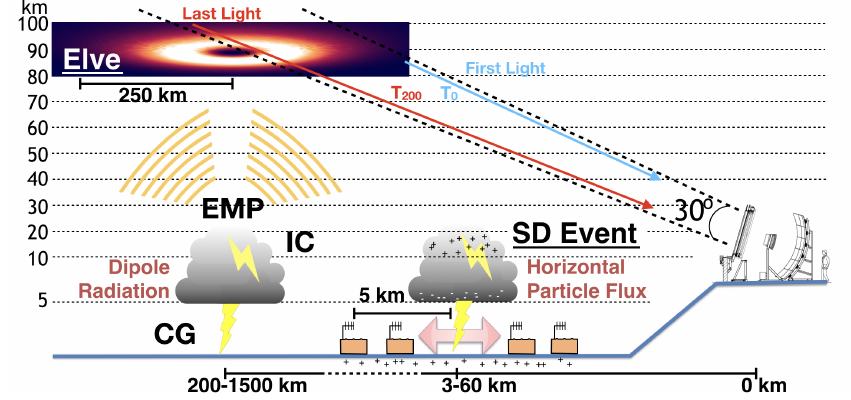
Figure 2. The FD sites are located on small hills above the SD. Due to atmospheric properties, cloud heights do not reach above 20 km. Negative cloud-to-ground lightning discharges are a few kilometers long. Two di ff erent phenomena are demonstrated in this diagram. Left: the return stroke process creates an electromagnetic pulse (EMP) which radiates to the ionosphere at 90 km altitude. When the EMP reaches the plasma, it creates a radially expanding flash of light, referred to as an ’elve’. The light at the nearest edge of the disk reaches the FD first, while the light above the lightning strike arrives later. Right: the cloud electrification induces positive charges on the ground. When the charges from the cloud travel downward to the ground, they will meet with the positive charges traveling upward to the cloud. This phenomenon is referred to as the attachment process. The attachment point of two, very localized leader tips, each with mega-volts of electric potential, may possibly be the source of particles seen in the